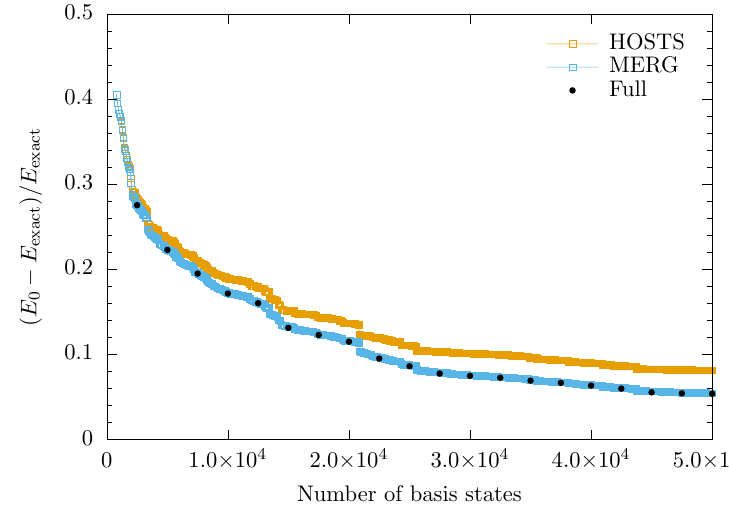
Figure 19: The convergence of the initial state energy E for N = 6 particle quench 0 = 100 → c = 3.7660 obtained with the matrix element renormalization group c i f = 720 and ∆ N = 80. Conventional numerical (MERG). MERG is performed with N s s renormalization group approaches breakdown in this scenario (for the same N , ∆ N ) s s as shown in Fig. 17. Full diagonalization results, for the same number of basis stats, are shown for